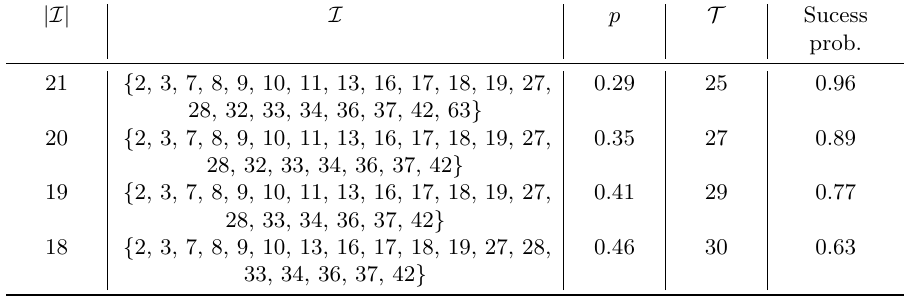
Table 5: Examples of weak key distinguishers (experimental) for 6 rounds Ascon